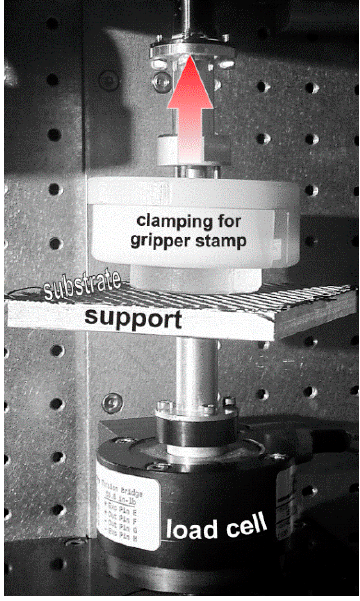
Figure 2. Component test set-up .